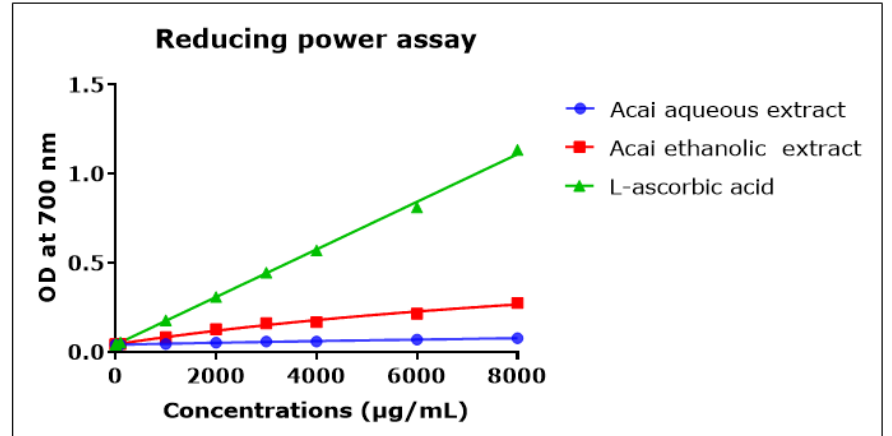
Figure 8. Reductive capacity of different concentrations of plant extracts from acai berry. Plant reducing power was measured by the ability to reduce ferric (Fe 3+ ) to ferrous (Fe 2+ ) iron (OD density change at 700 nm). The positive control was L-ascorbic acid (vitamin C). Assays were performed in triplicate at each extract concentration ( n = 6).